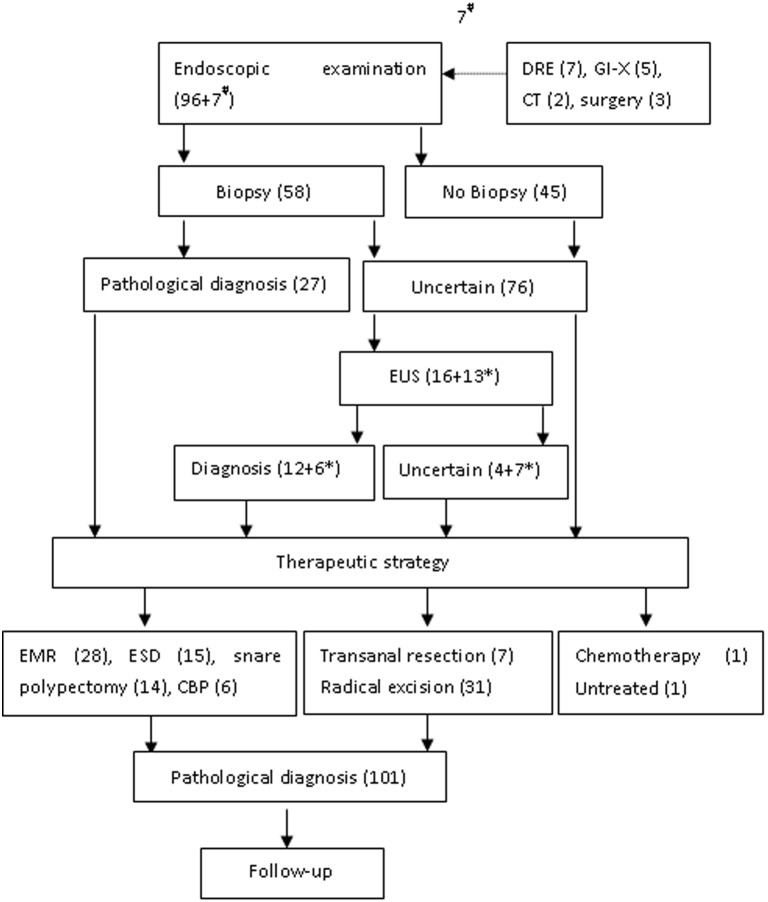
Diagnostic chart of gastrointestinal NEN.DRE: digital rectal examination; GI-X: gastrointestinal X-ray barium meal examination; CT: computed tomography; EUS: endoscopic ultrasonography; CBP: cold biopsy forceps polypectomy; EMR: endoscopic mucosal resection; ESD: endoscopic submucosal dissection; #non-endoscopically discovered lesions which were further confirmed by endoscopy; *the patients examined by EUS and taken biopsy at the same time.